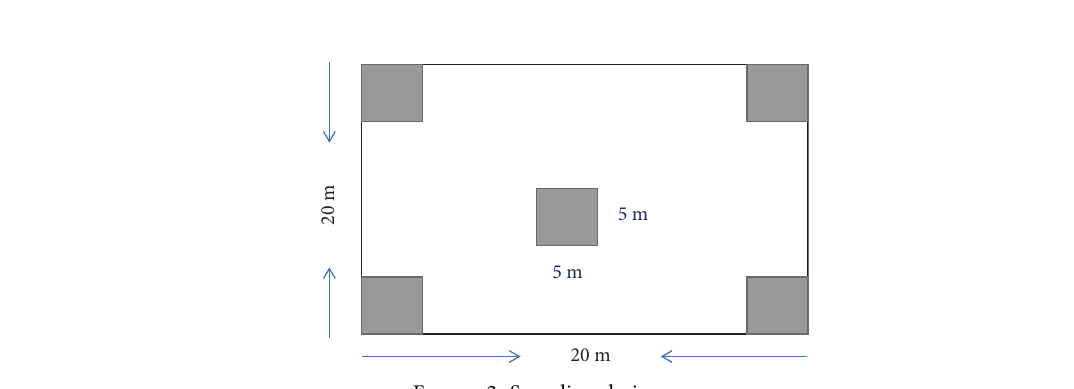
Figure 1: Map of the study area.